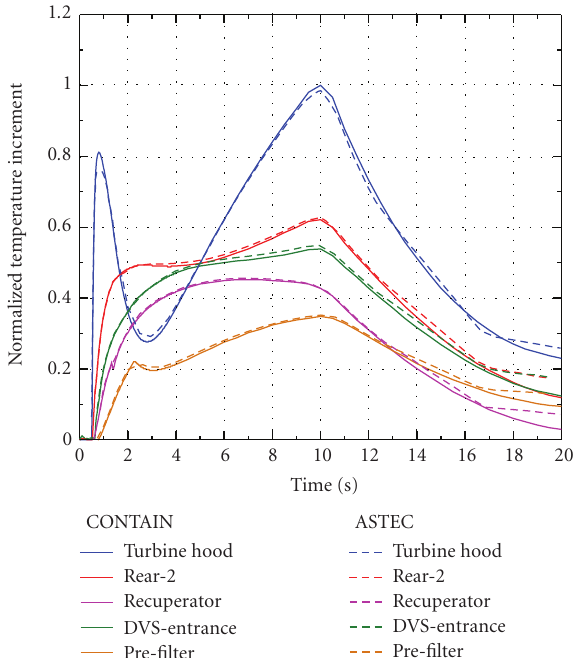
Figure 4: Pressure evolution in the main confinement compart- ments for the LB sequence. Figure 5: Temperature evolution in the main confinement com- partments for the LB sequence.